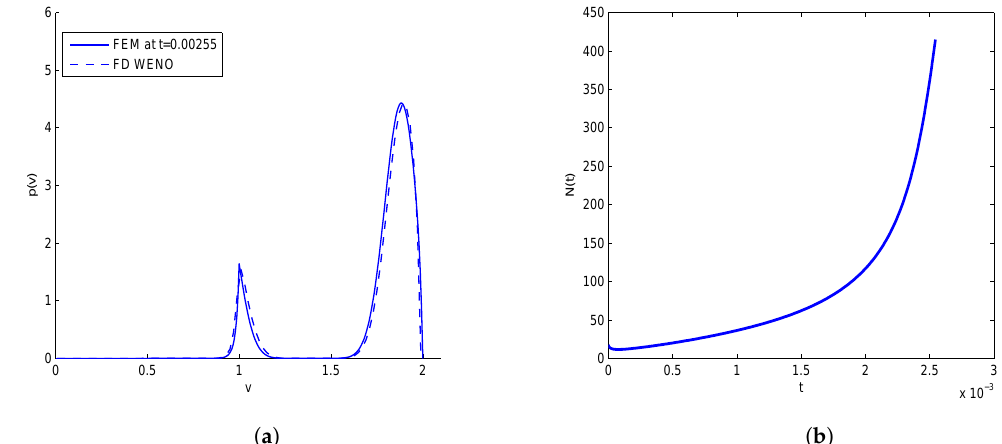
Figure 4. Left: The approximate solution p ( v , t ) , Right: Firing rate N ( t ) for initial data given in = 0.003. The system is considered for the Equation (20) with mean v 0 = 1.83 and variance σ 2 0